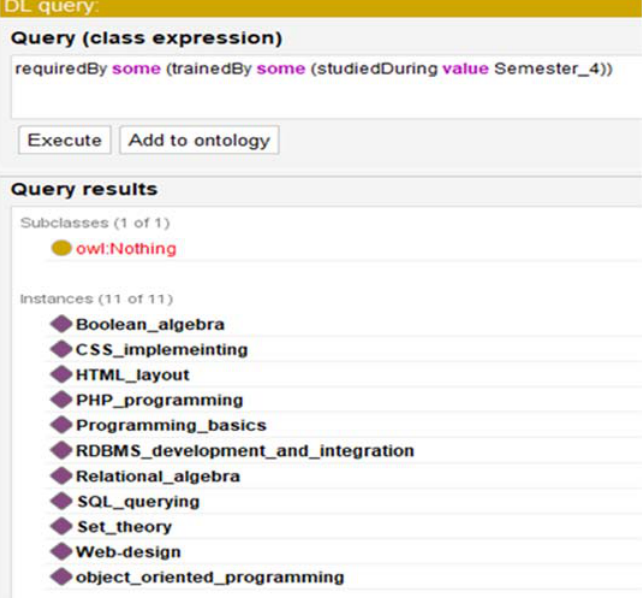
Figure 10. The list of skills that are the entrance requirements for the courses of the 4th semester.